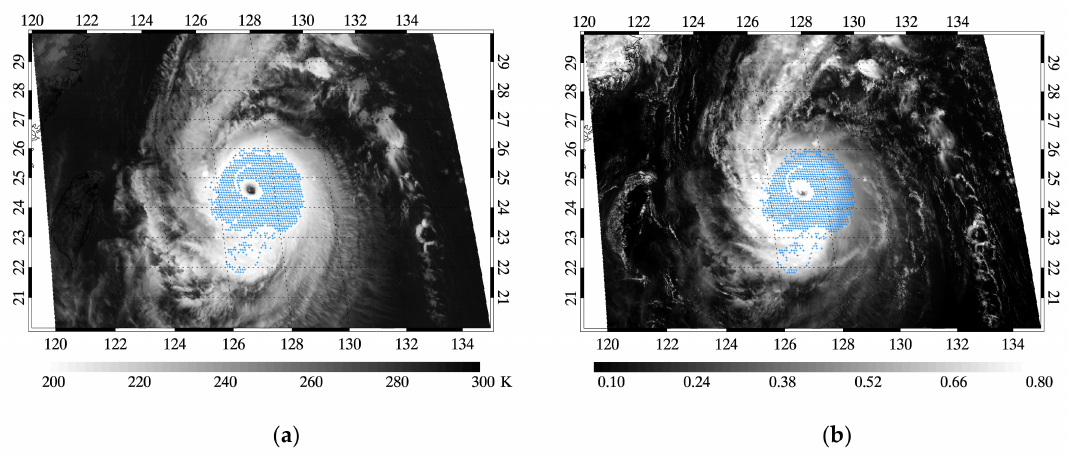
Figure 7. AHI DCCs plotted as blue dots on ( a ) 2-km AHI TB 10.4 and ( b ) 2-km R 0.47 images of Typhoon Chaba (3 October 2016 03:30 UTC)